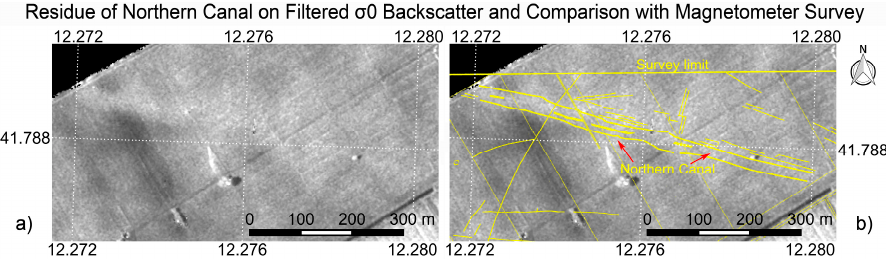
Figure 9. ( a ) Residue of Northern Canal on image of filtered σ 0 backscatter acquired on 16 November 2011; ( b ) Overlain with features interpreted by magnetometry survey published by Keay et al., 2005 [43]. COSMO SkyMed data provided by the Italian Space Agency. Vectors of interpreted features, copyright Keay et al., 2005 [43].